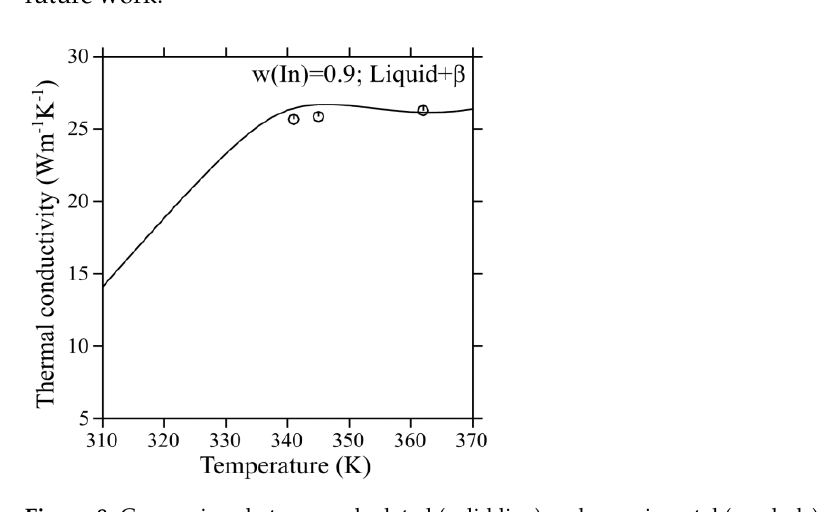
Figure 8. Comparison between calculated (solid line) and experimental (symbols) thermal conductivities of Ga-In alloy at w(In) = 0.9 in the L + β two-phase region .